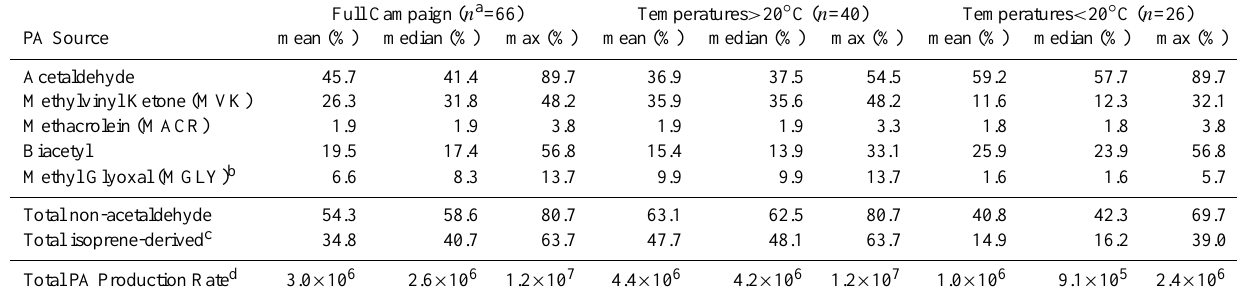
Table 4. Summary of PA radical sources for entire campaign, temperatures above 20 ◦ C, and temperatures below 20 ◦